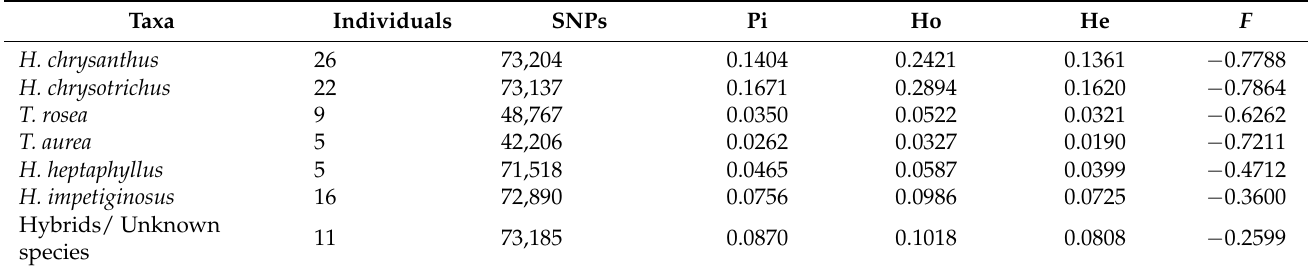
Table 3. Genetic diversity of the 7 taxa.